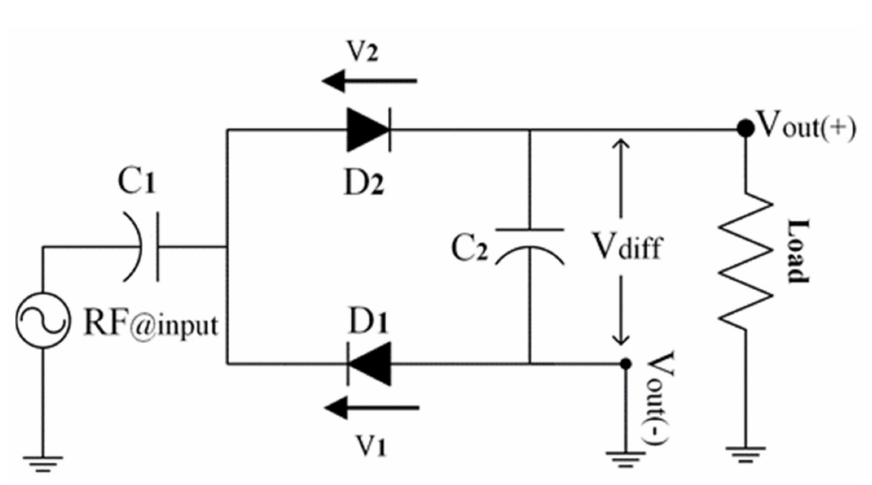
Figure 13. Proposed rectifier